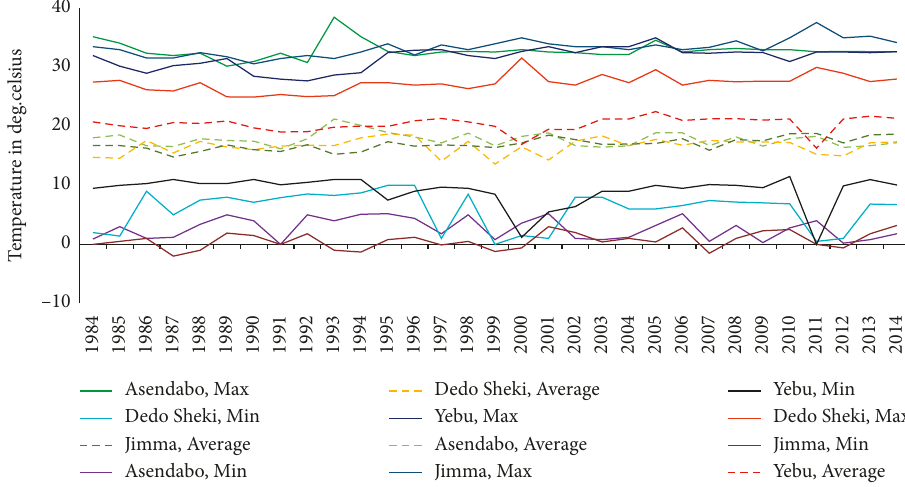
Figure 4: Time series of temperatures